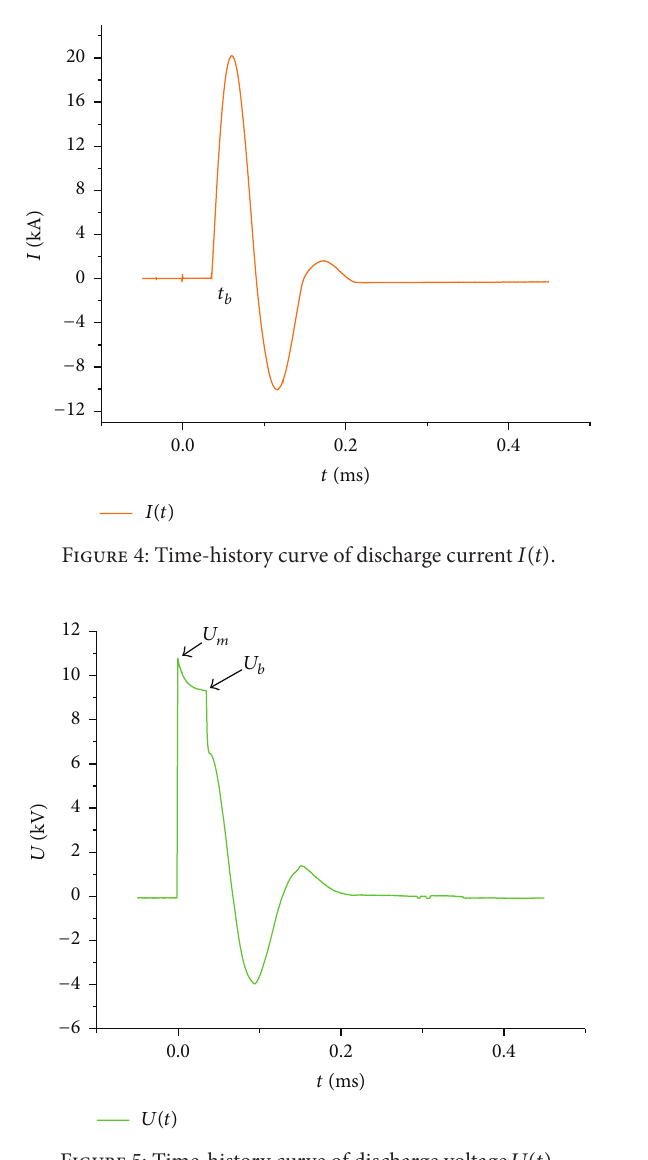
Figure 5: Time-history curve of discharge voltage 𝑈(𝑡) .